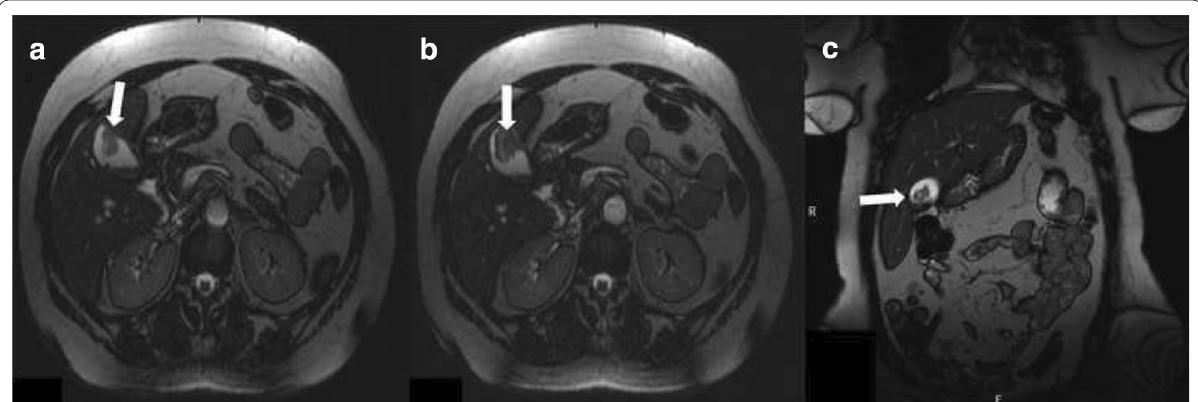
Fig. 2 Axial ( a , b ) and coronal ( c ) T2-weighted MRI images of an asymptomatic 59-year-old female underwent surgery for a right scapular melanoma 4 years before, with no evidence of metastatic disease at the primary staging. MRI was recommended after a US examination reporting a nonspecific gallbladder mass. The patient was in good general health, nutritional and hydration status. No palpable masses were observed at the clinical examination. MRI images showed a vegetant endoluminal hypointense mass with broad mural base and focal wall thickening. A cholecystectomy was performed and a metastasis from melanoma was histologically